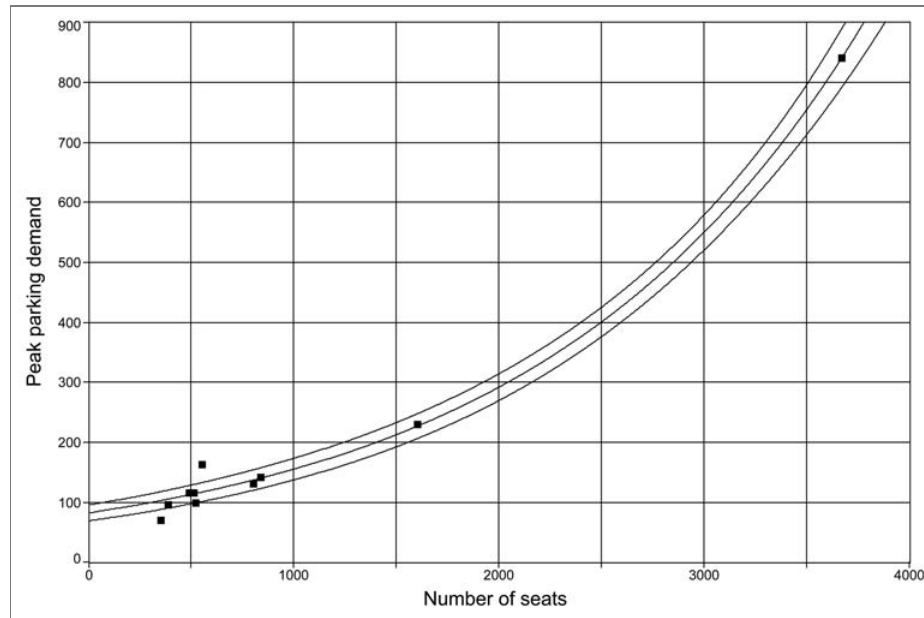
Fig. 6. Dependence of peak parking demand upon number of seats (selection of surveyed developments which will serve as the basis for definition of basic